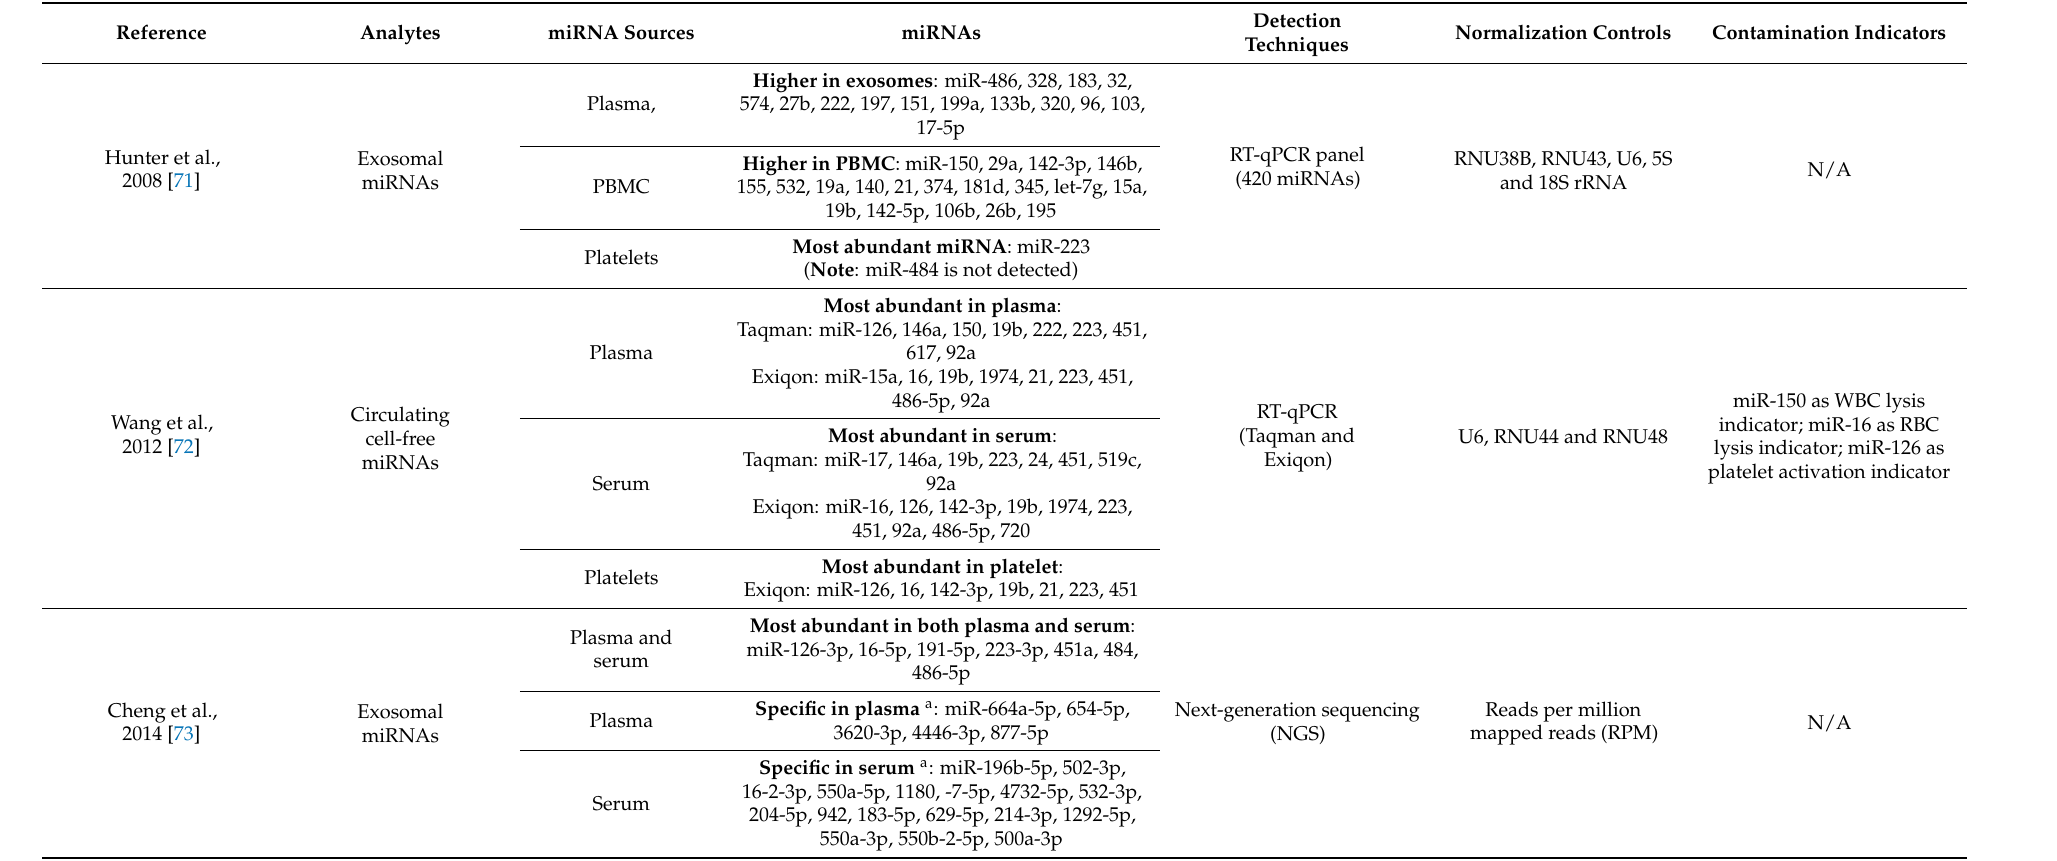
Table 3. Exosomal miRNAs and circulating cell-free miRNAs showing differential expression between various bioliquid sources. N/A: not